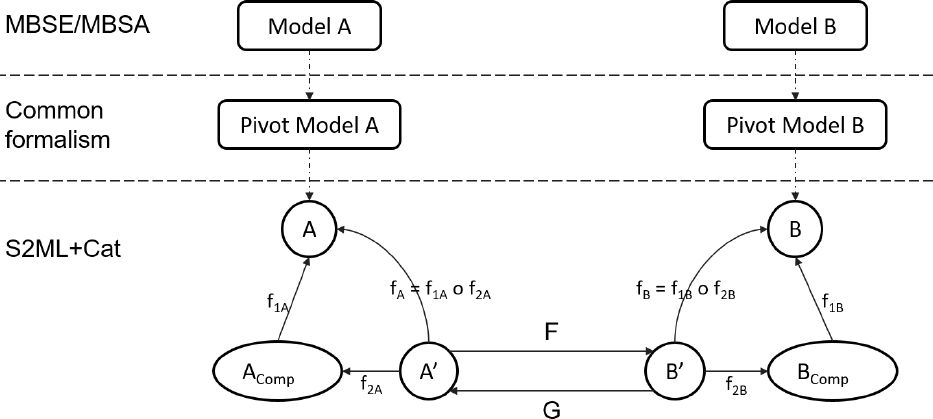
Figure 11. Structure for binary consistency